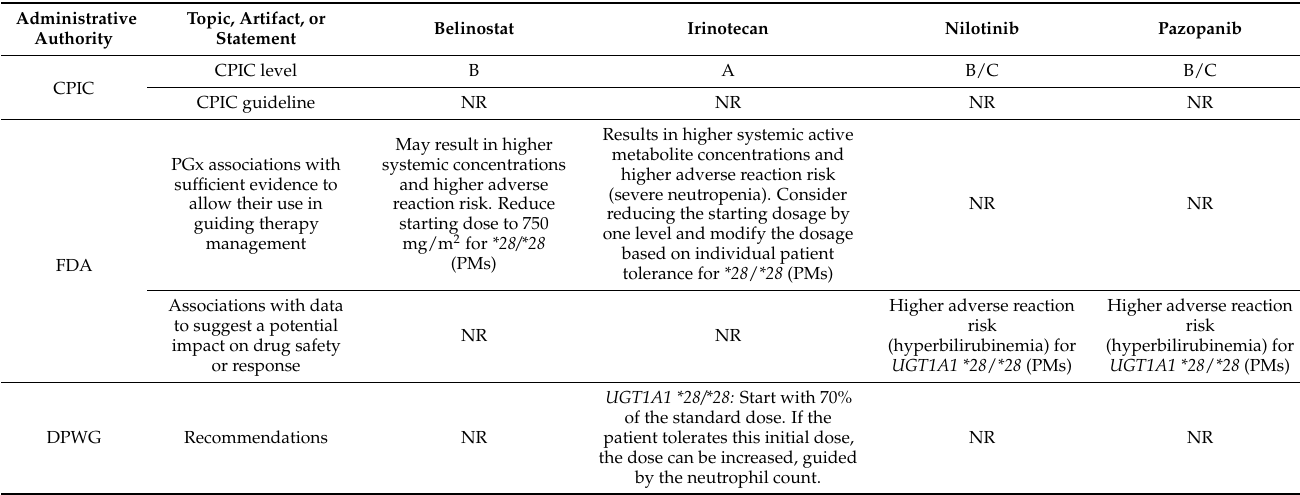
Table 5. Comparison of UGT1A1 pharmacogenetic recommendations between guideline and administrative